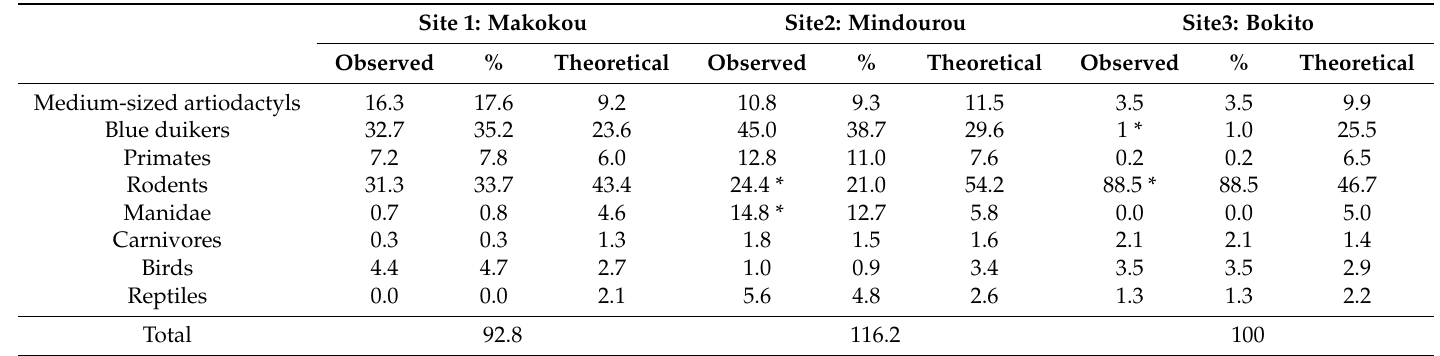
Table 3. Number of prey per hunter, observed and theoretical, in the three study sites.